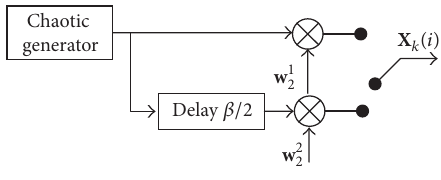
Figure 2: Block diagram of OCG.